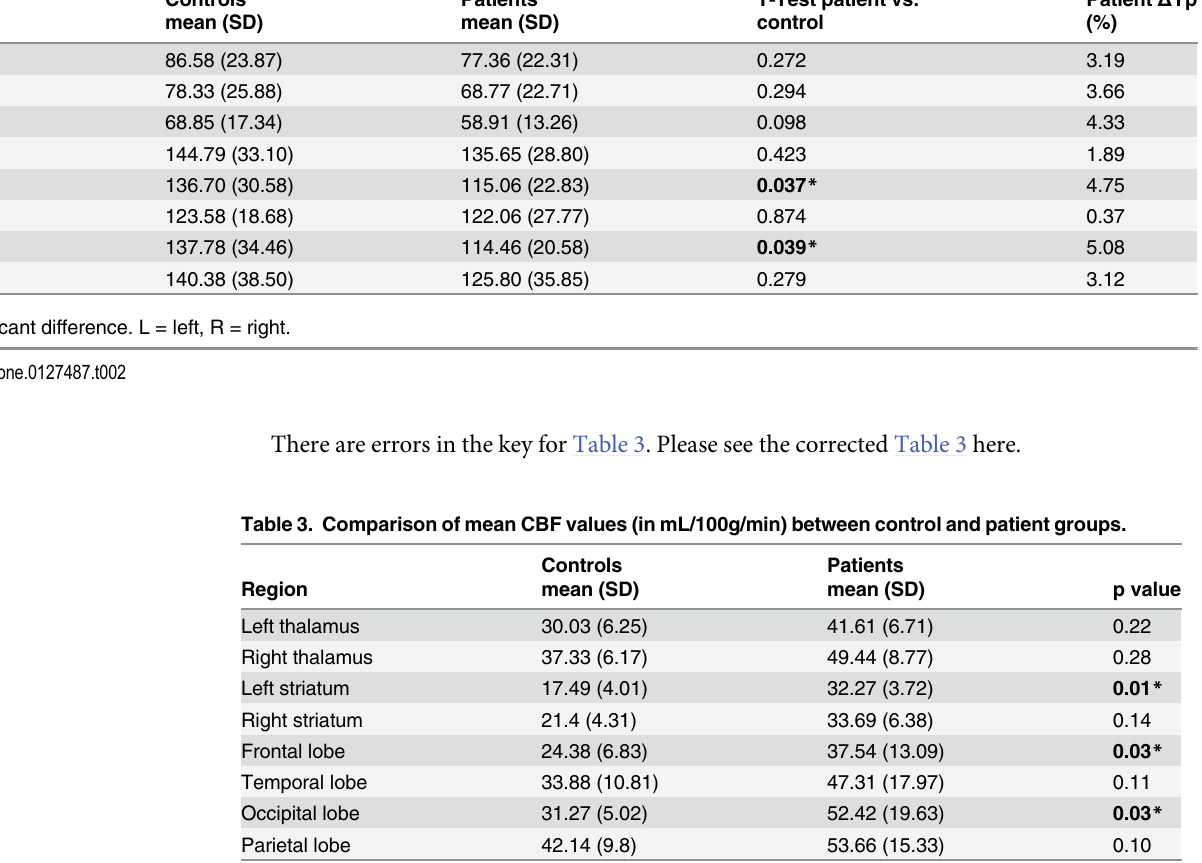
There are errors in the key for Table 4. Please see the corrected Table 4 here.